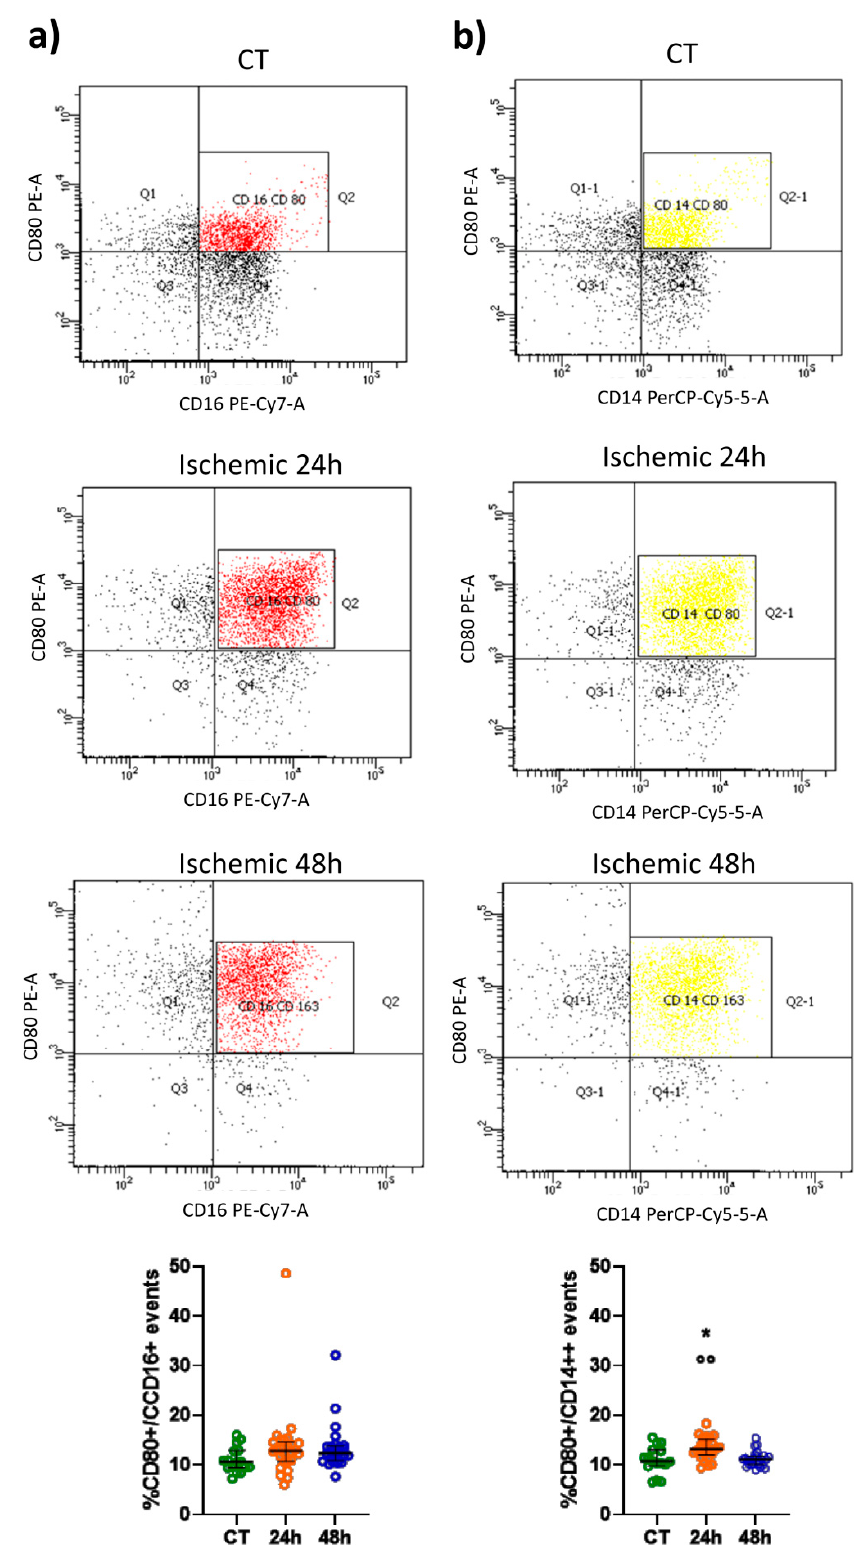
Figure 2. Representative flow cytometry density plots and scatter plots showing the percentage of CD80+/CD16+ (red) ( a ) and CD80+/CD14++ (yellow) ( b ) events in healthy subjects (CT; n = 16) and in patients 24 and 48 h after an ischemic stroke ( n = 26). Data are shown as the median and interquartile range. A Kruskal–Wallis test, followed by Dunn’s post-hoc test: * p < 0.05 vs. CT; Wilcoxon’s signed-rank test: ◦◦ p < 0.01 vs. 48 h.